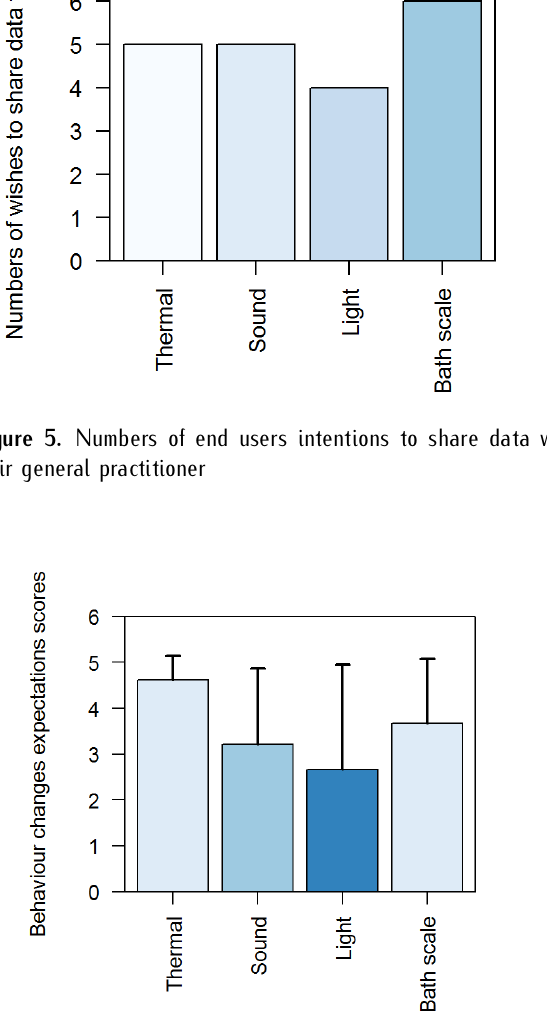
Figure 6. End users behaviour change expectations means